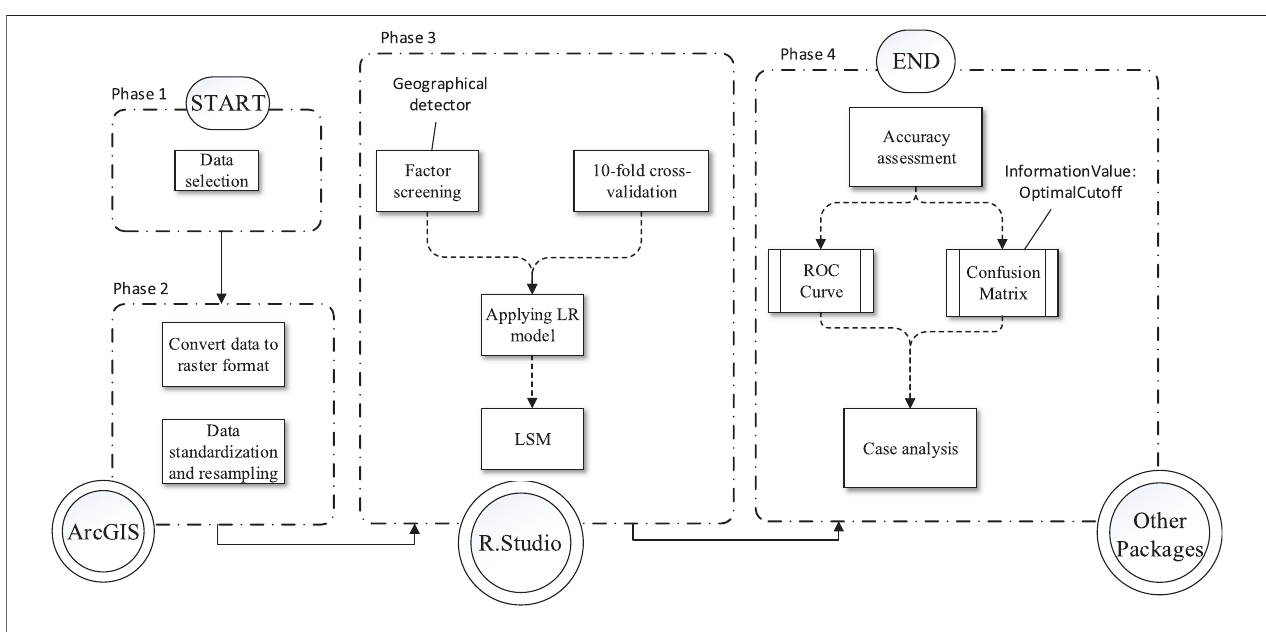
FIGURE 2 | Methodological fl owchart used in this